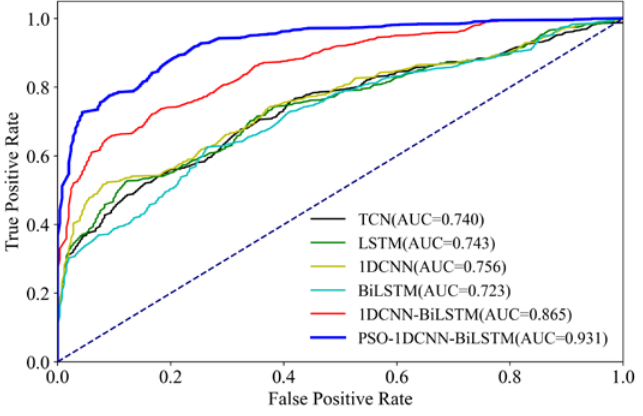
Figure 7. ROC curve.